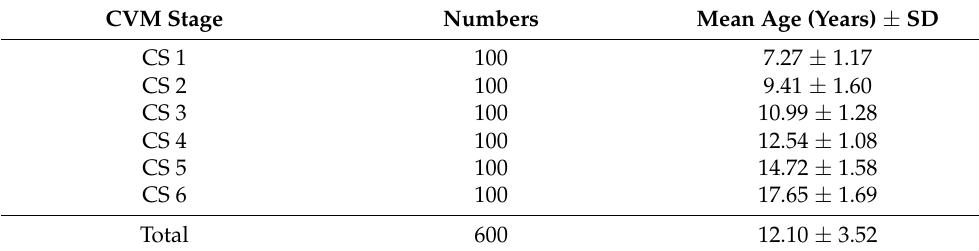
Table 1. Descriptive statistics of the subjects’ age by cervical stage.